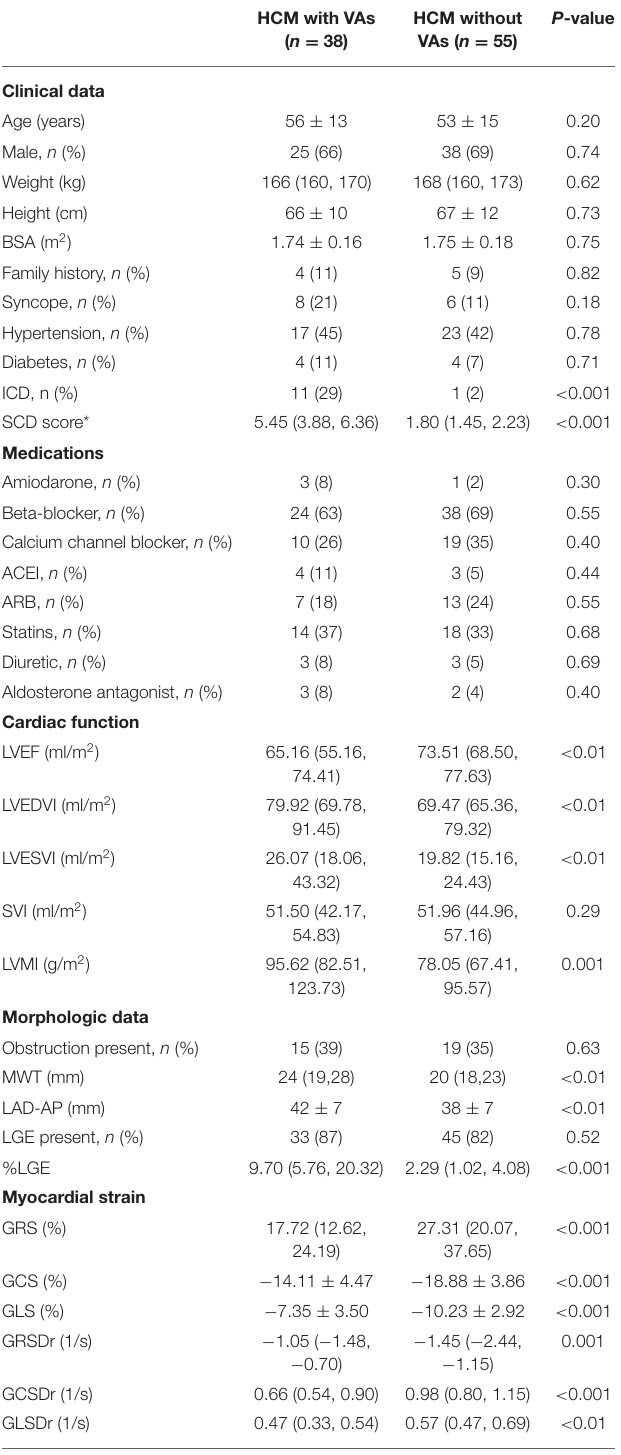
TABLE 2 | Clinical characteristics and CMR findings in HCM patients with and without VAs.